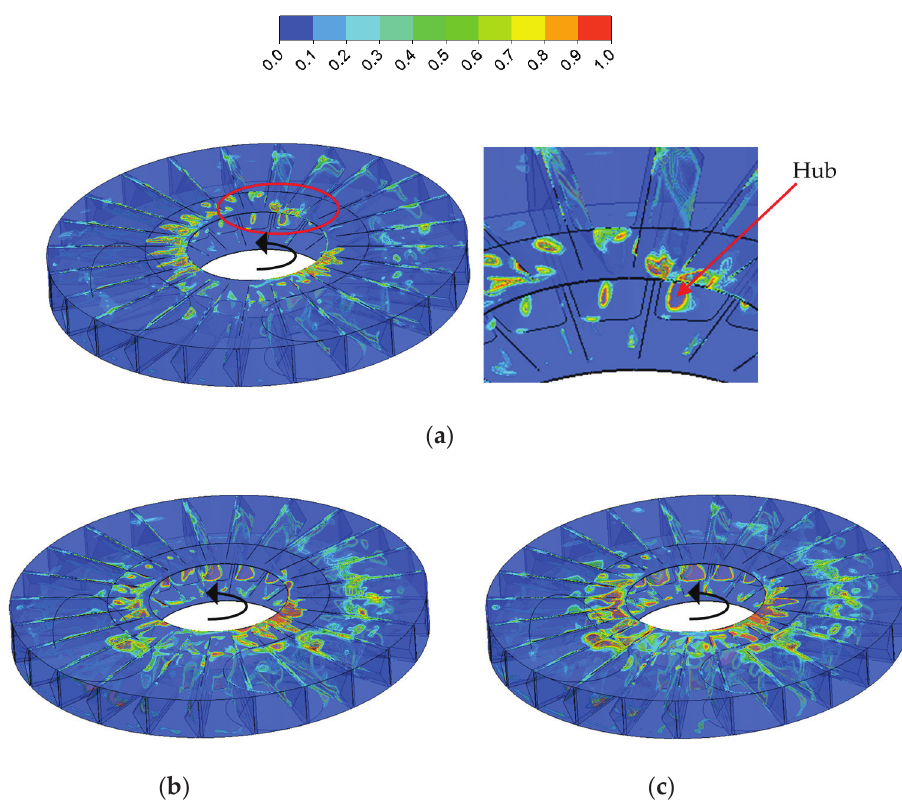
Figure 16. Gas volume fraction distribution under different IGVF. ( a ) IGVF 2%, ( b ) IGVF 4%, ( c ) IGVF 6%.